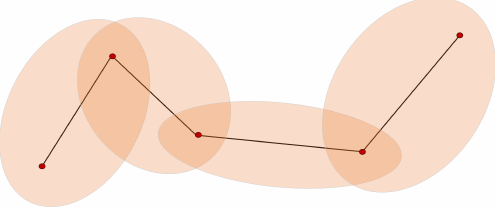
Figure 8. A “winding” line with wide ellipses.